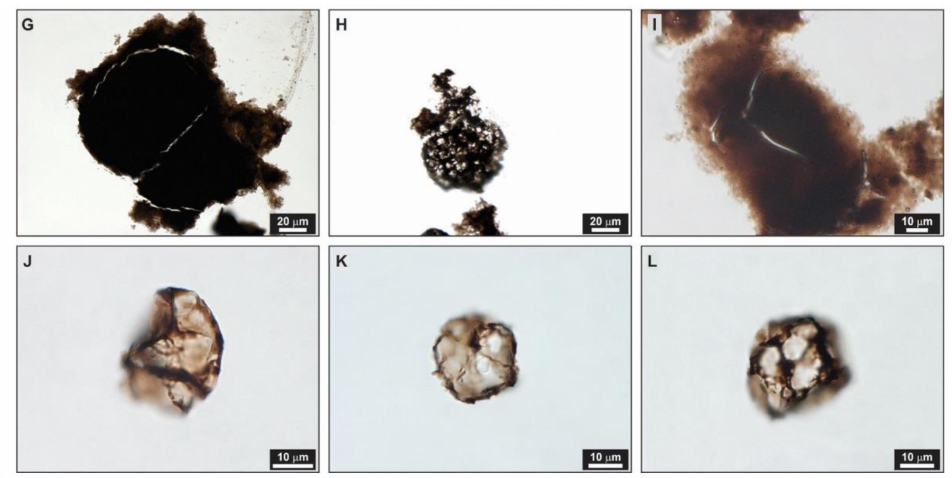
Figure 3. Photomicrographs of solid bitumen and spores in isolated kerogen slides. Transmitted white light ( A , C , D , F – L ); fluorescence mode ( B , E ).